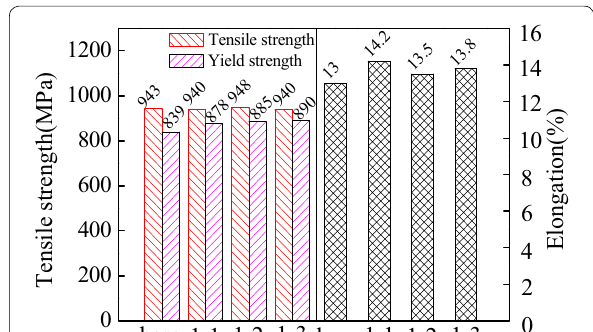
Figure 14 Tensile mechanical properties at room temperature